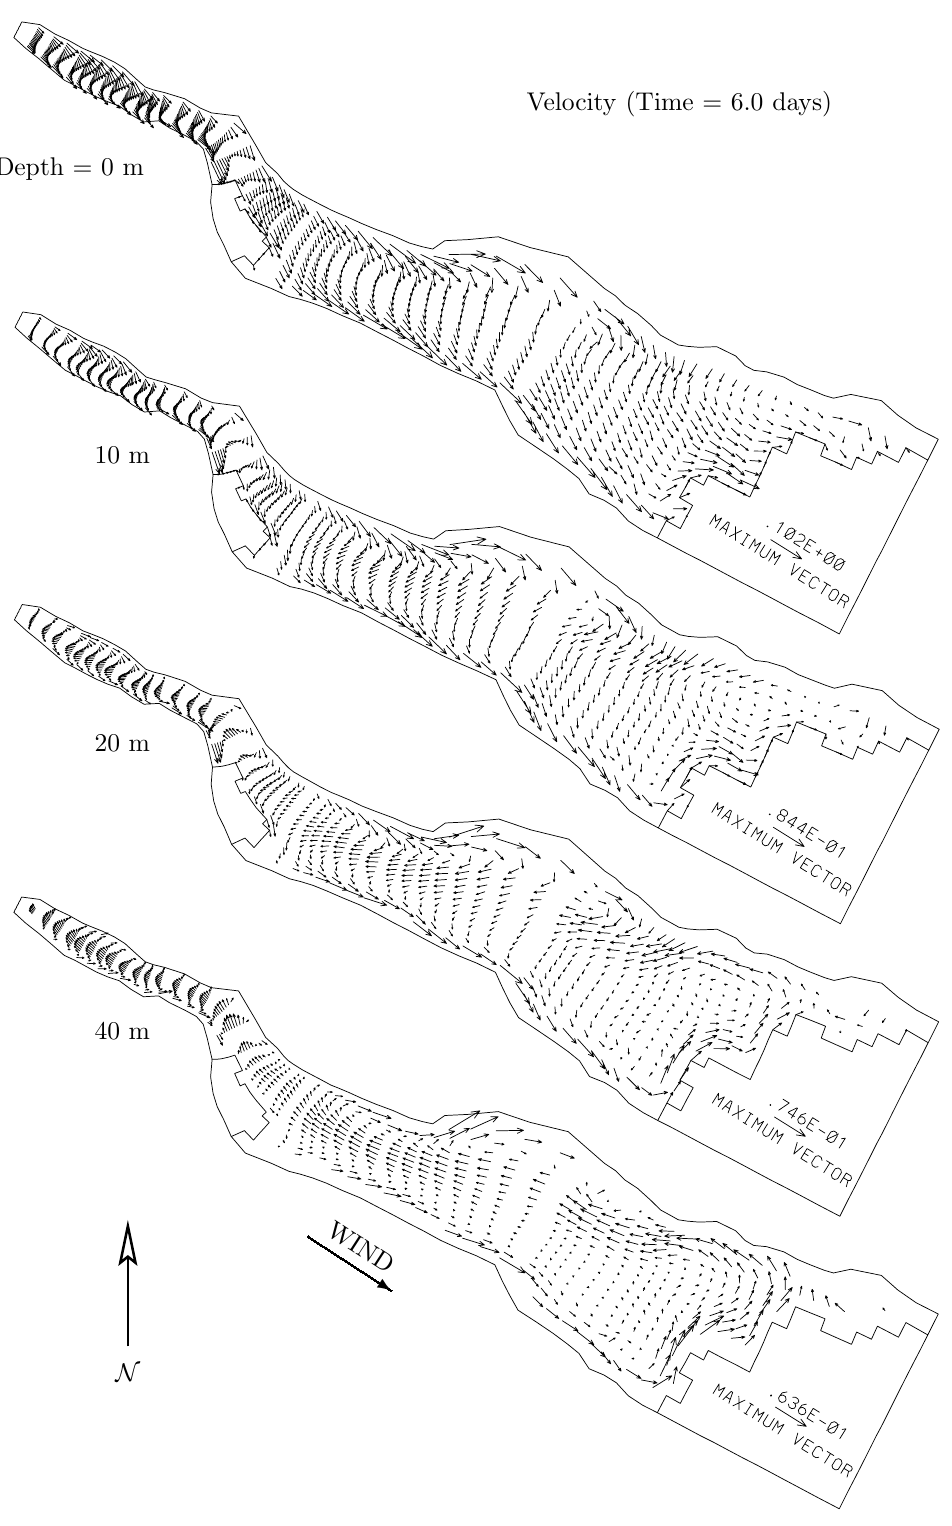
FIG. 10: Velocity vectors, 6 days after a constant northwest wind (305 ◦ NW in the longitudinal direction ◦ NW in the longitudinal direction of the basin) started, in 0 m, 10 m, of the basin) sets up in 0 m, 10 m, 20 m and 40 m depth. Each panel has its own velocity scale. Fig. 10. Velocity vectors, 6 days after a constant northwest wind (305 20 m and 40 m depth. Each panel has its own velocity